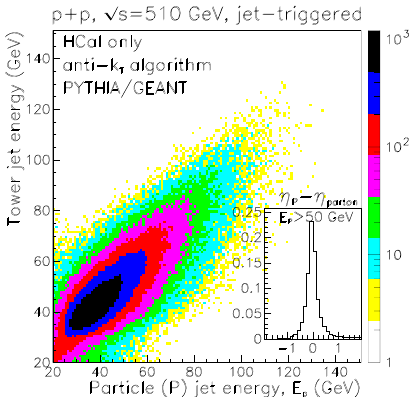
Figure 10. Comparison of results from the anti-k T algorithm ap- plied to full PYTHIA + GEANT simulations versus events gen- erated by PYTHIA [53]. The inset shows the directional match between particle jets and hard-scattered partons, and results in an 82% match when | Δ η | , | Δ φ | < 0 .